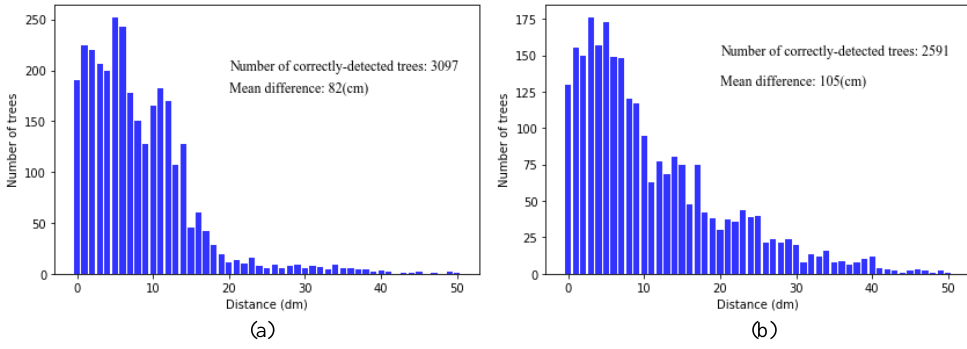
Figure 15. Distribution of distances between the LiDAR-derived tree locations and the on-site measured tree locations for all correctly-detected trees. ( a ) Multi-threshold and ( b ) DSM-based. Remote Sens. 2018 , 10 , x FOR PEER REVIEW After matching the lidar-derived trees with the field trees, we can also estimate the crown sizes.